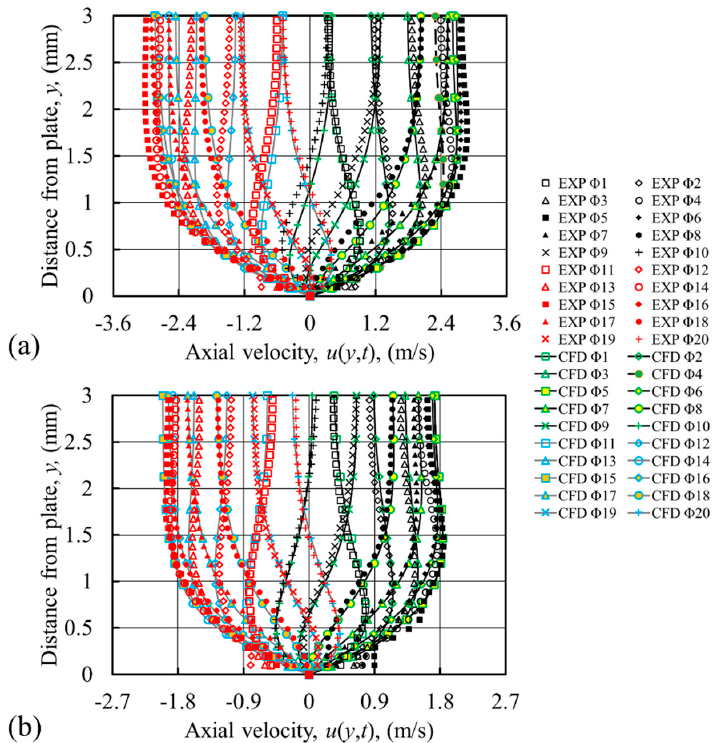
Figure 14. Comparison between velocity profiles from the experiment and the SST k- ω model; for